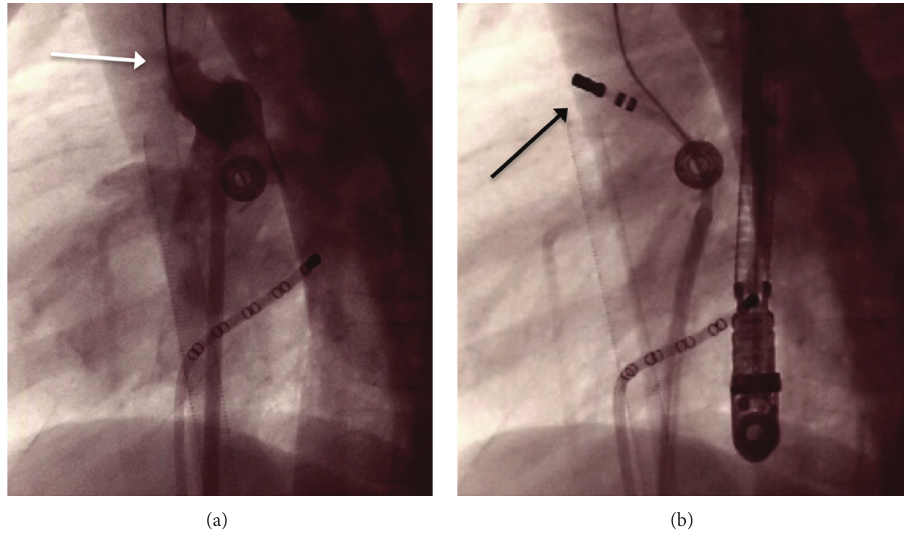
Figure 2: LAO 90 degree contrast injection of LAA ((a) marked by white arrow) and successful ablation site (black arrow in (b)).